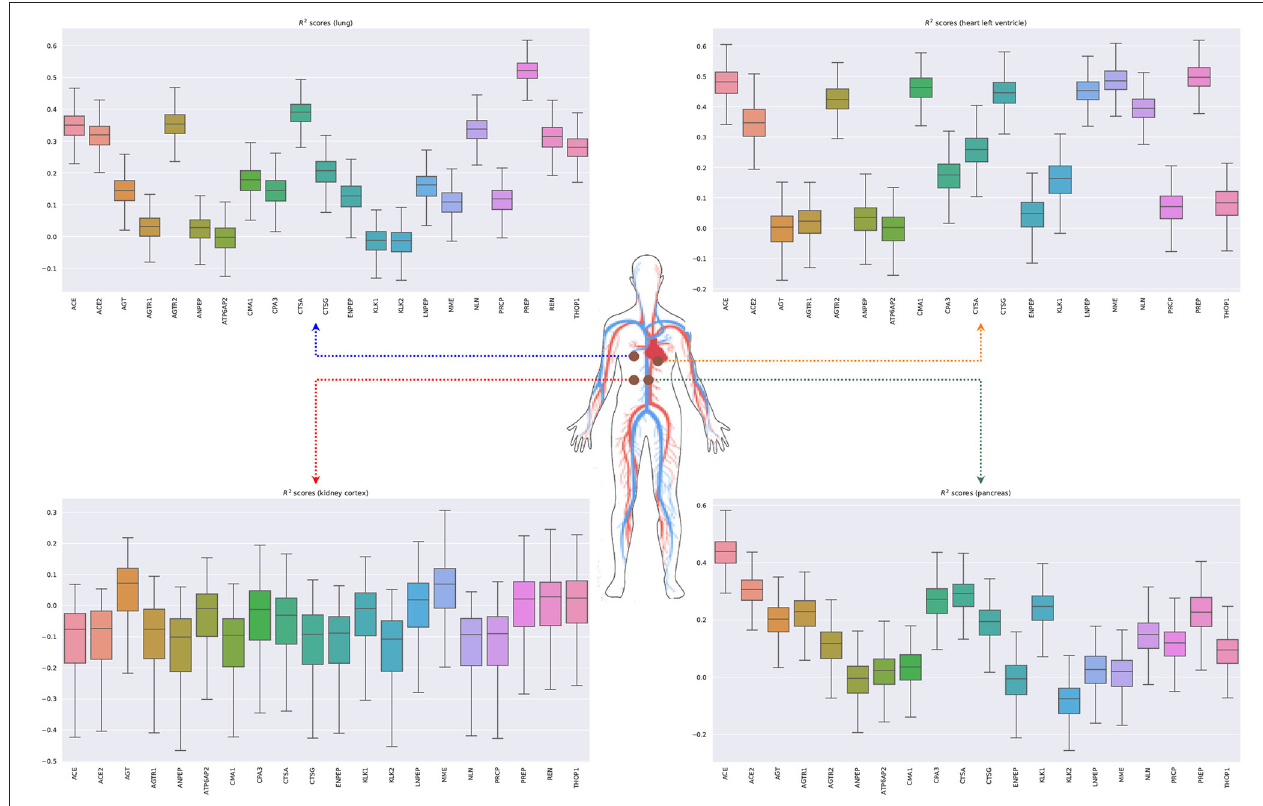
FIGURE 6 | Bootstrapped R 2 scores for genes involved in the renin-angiotensin system for lung, heart (left ventricle), kidney (cortex), and pancreas. The input variables are the expressions of genes in whole blood belonging to the chemokine, TNF, and TGF- β pathways.